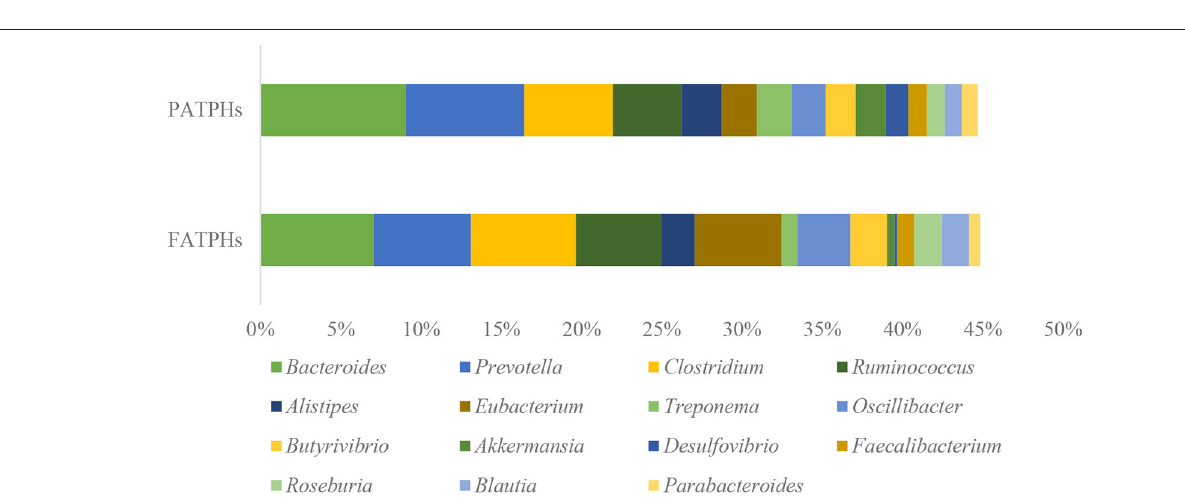
FIGURE 4 | Top relative abundances of the well-classified bacterial genera ranked by zero order of magnitude in PATPHs shown together with the relative abundances of the corresponding genera in